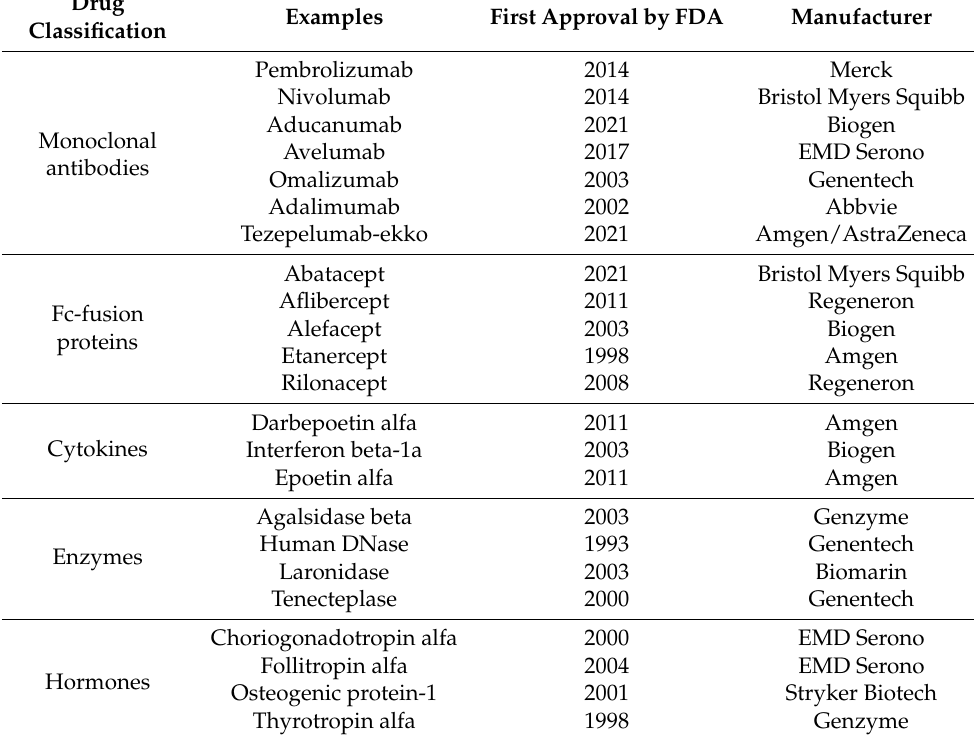
Table 1. Examples of approved Chinese Hamster Ovary (CHO) cell-derived biotherapeutics. Non- exhaustive list compiled from publicly available resources (https://www.accessdata.fda.gov/scripts/ cder/daf/index.cfm?event=BasicSearch.process), US Food and Drug Administration, (last accessed 10 January 2022), European Medicines Agency